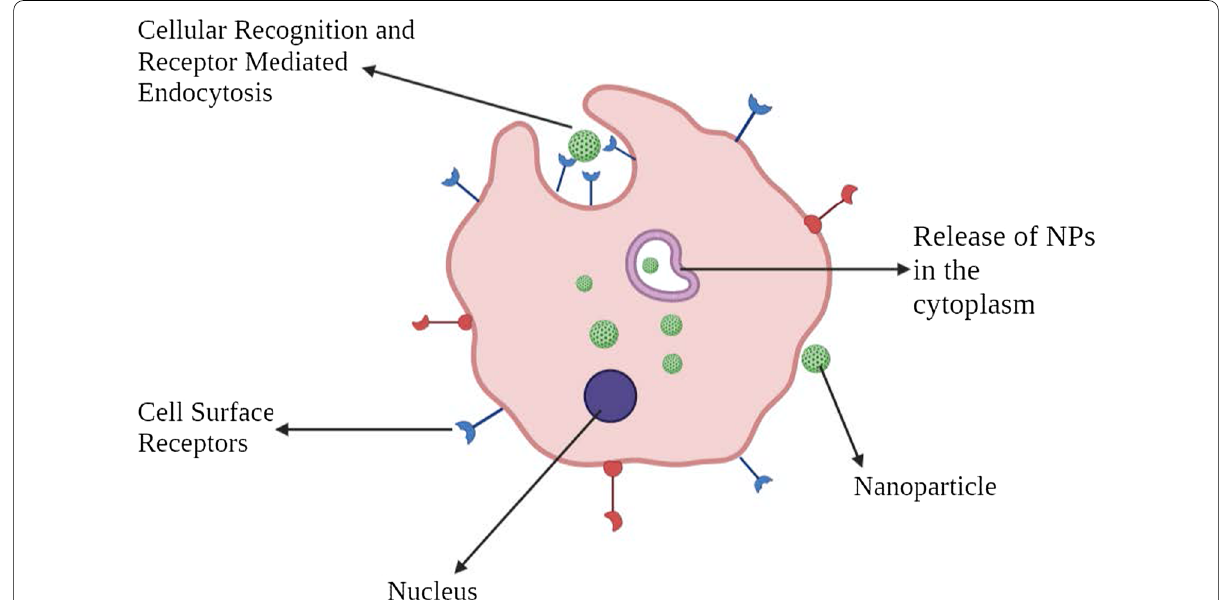
Fig. 4 Pictorial representation of active cellular